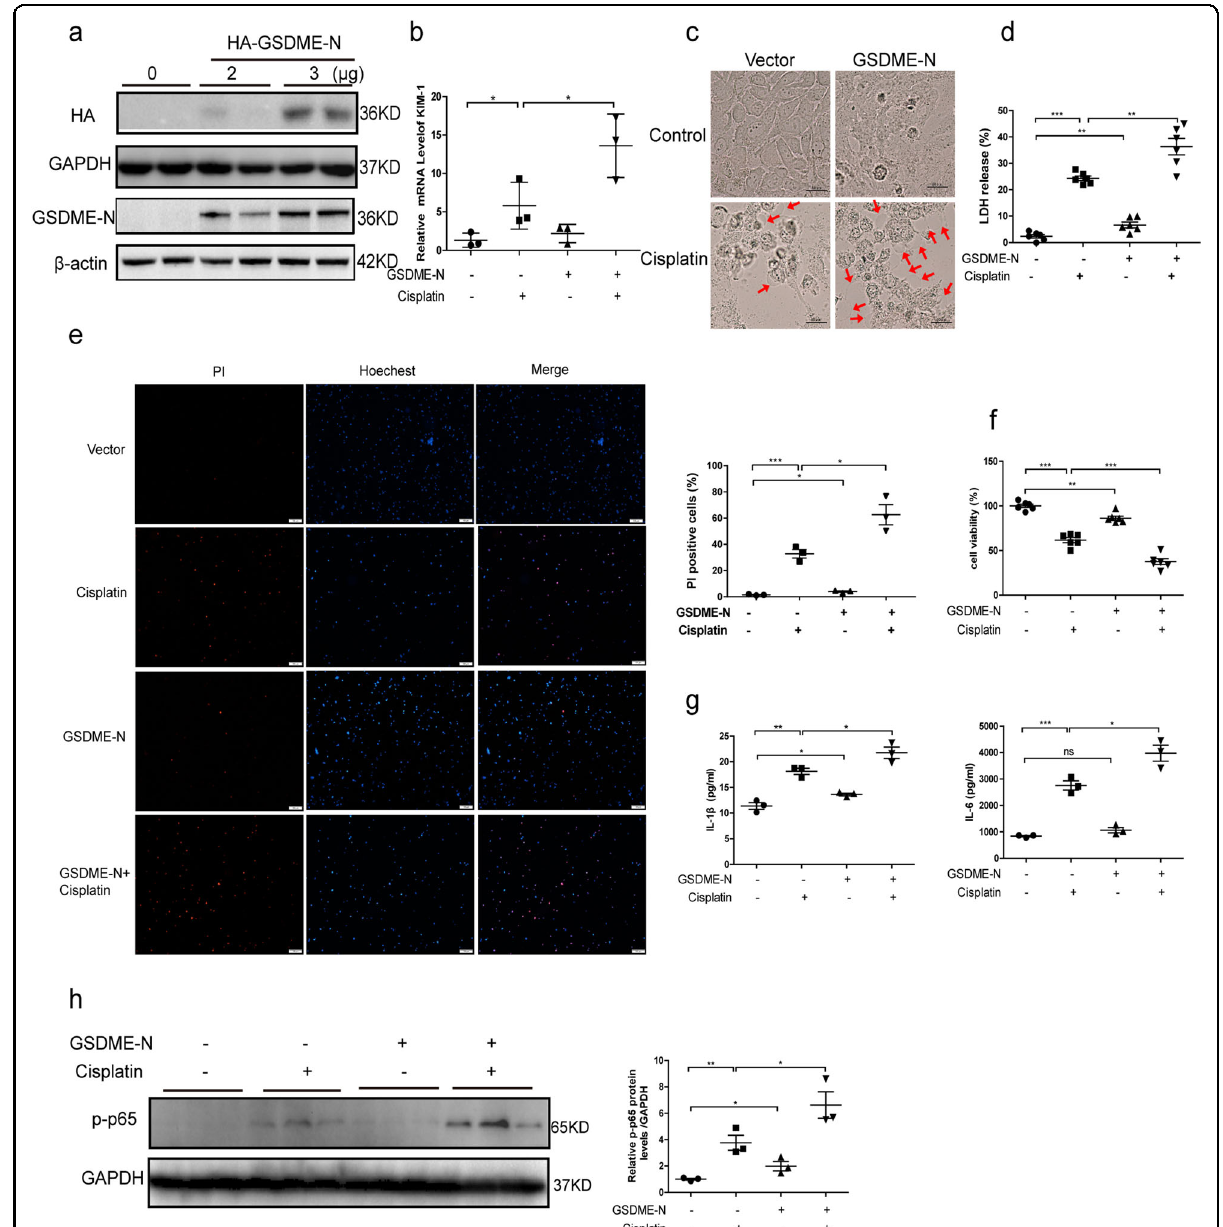
Fig. 4 GSDME-N promoted cisplatin-induced cell injury and pyroptosis in human TECs. Human TECs (HK-2) were transfected with GSDME-N (residues 1 – 270aa) overexpressing plasmid and subsequently treated with cisplatin (10 μ g/mL) for 24 h. a Protein levels of HA-GSDME-N in cells by immunoblotting with HA and GSDME antibody. b Transcriptional levels of KIM-1 ( n = 3). c Representative bright- fi eld microscopic images of cells treated with cisplatin in the presence or absence of GSDME-N. Red arrowheads indicate large bubbles from the plasma membrane (scale bar = 50 μ m). d LDH release of cells transfected with GSDME-N in the presence of cisplatin treatment ( n = 6). e PI staining of cells with GSDME-N overexpression (scale bar = 100 μ m; n = 3). f CCK-8 assay was performed to assess the effect of GSDME-N on cell viability ( n = 6). g ELISA results of IL- 1 β and IL-6 in cultured medium of cells with GSDME-N overexpression ( n = 3). h The effect of GSDME-N on p-p65 protein levels ( n = 3). * P < 0.05, ** P < 0.01, and *** P <